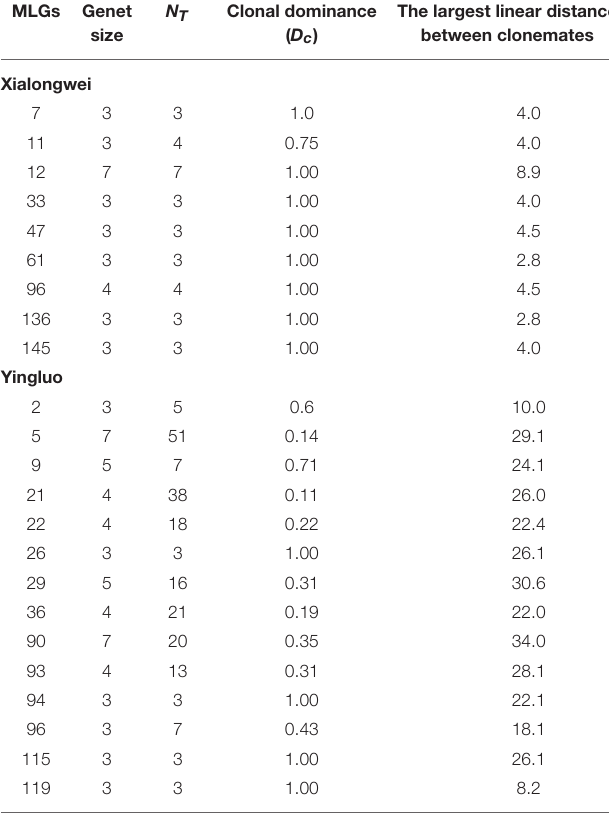
TABLE 2 | Genet size (the number of sampling ramets per genet) and clonal dominance of Halophila ovalis in Xialongwei and Yingluo sites. N T Clonal dominance MLGs Genet size ( D c